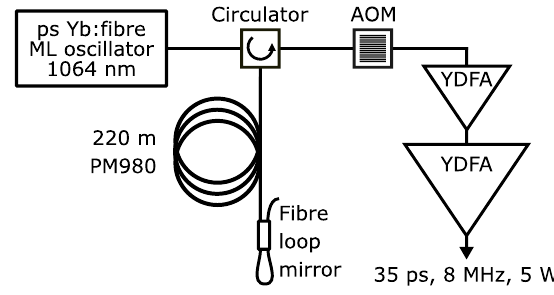
Figure 2. In-house developed ytterbium fiber master oscillator power amplifier system. ML, mode-locked; AOM, acousto-optic modulator; YDFA, ytterbium-doped fibre